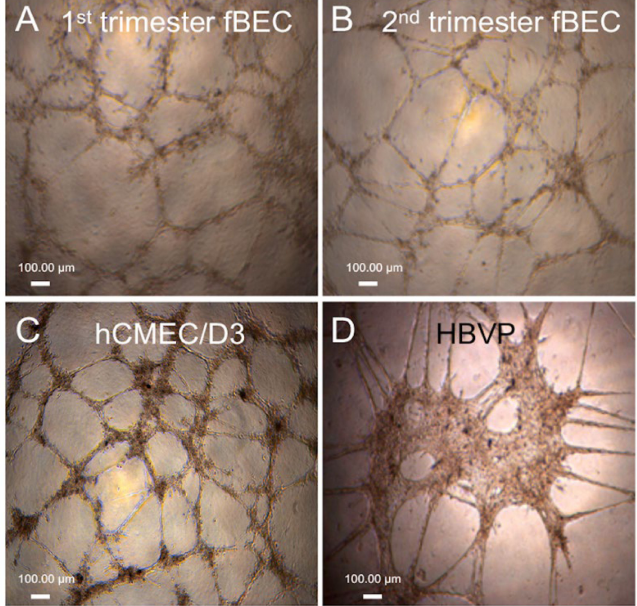
Figure 2. Tube formation in early and mid-gestation primary human fetal brain endothelial cells (hfBECs) . ( A ) early pregnancy hfBECs, ( B ) mid-pregnancy hfBECs, ( C ) adult endothelial cell line (hCMEC/D3) as positive control, and ( D ) human brain vessel pericyte cell line (HBVP). Tube forma- tion was assessed after 24 h. n = 6/gestational age (representative images